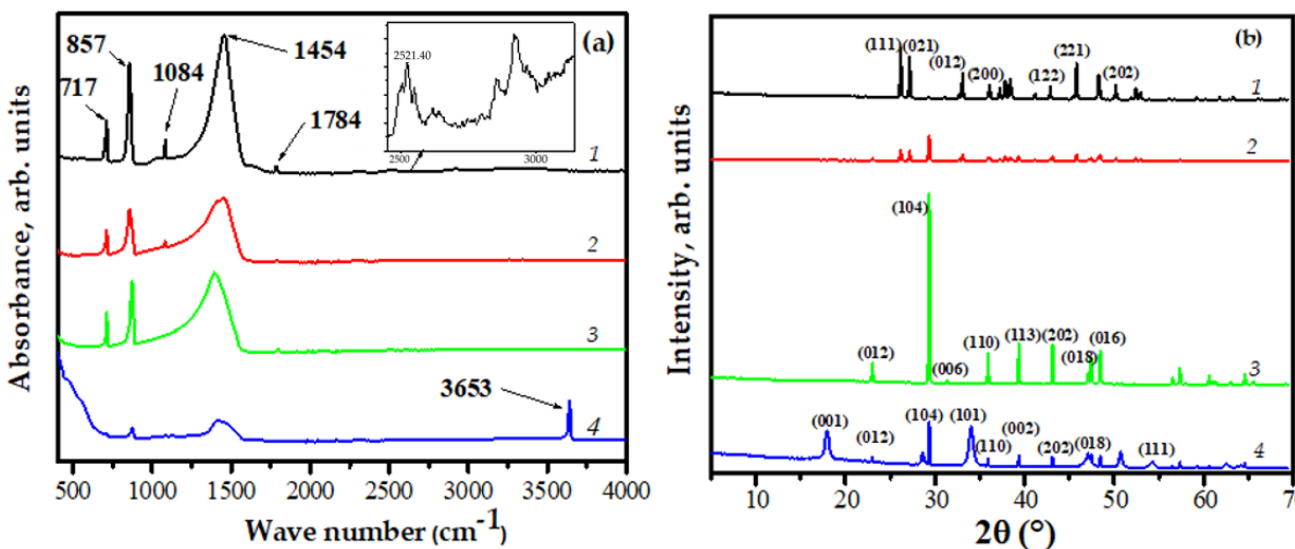
Figure 1. ( a ) FTIR spectra and ( b ) Powder X-ray diffraction patterns of (1) escN, (2) esc400, (3) esc700 and (4) esc 1000.